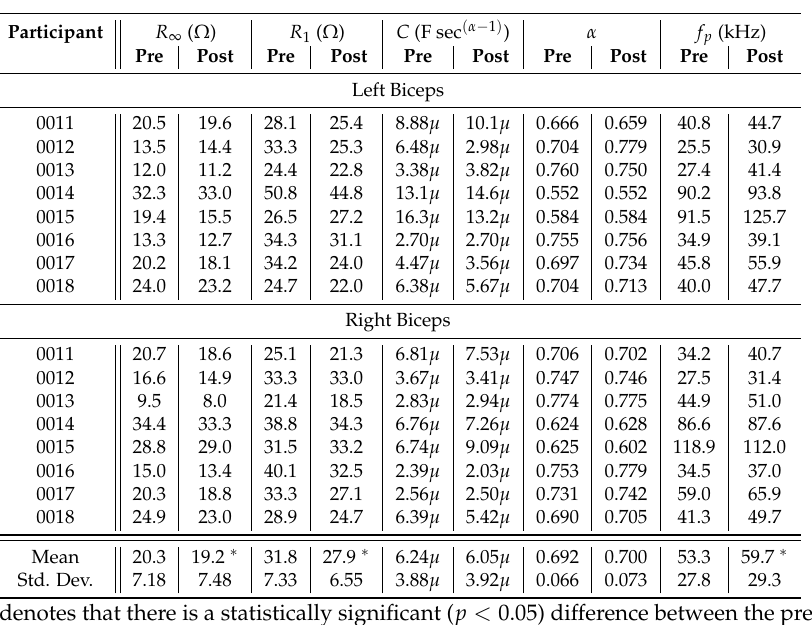
Table 2. Extracted equivalent circuit parameters from pre- and post-fatigue impedance measured from the left and right biceps of participants in the 75% 1-RM group.